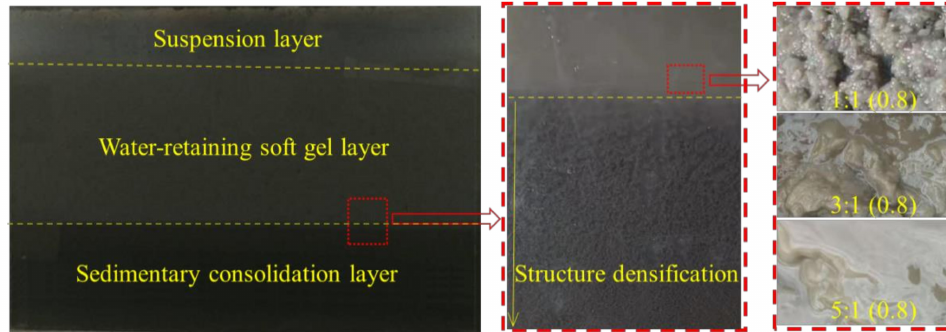
Figure 4. Deposition and stratification characteristics of CSG in water.